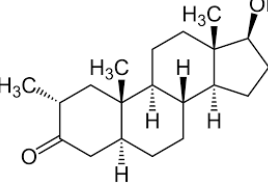
Figure 16. Chemical structure of EPO. Formula: C 815 H 1317 N 233 O 241 S 5. Physiological effect: Stimulation of erythroid progenitors [23]. It stimulates the pro- duction of red blood cells in the bone marrow and regulates the concentration of red blood cells and hemoglobin in the blood. Red blood cells carry oxygen to cells, including muscle cells, enabling them to function more efficiently.